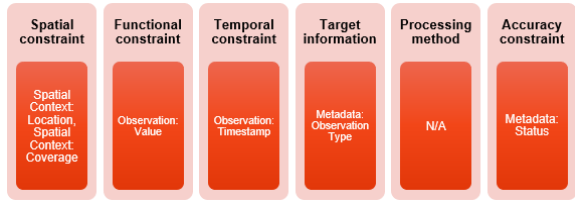
Figure 4. Relationship between sensor information and query constraints